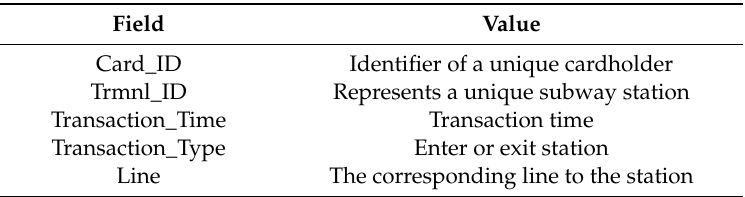
Table 1. Record format of the smart card dataset.